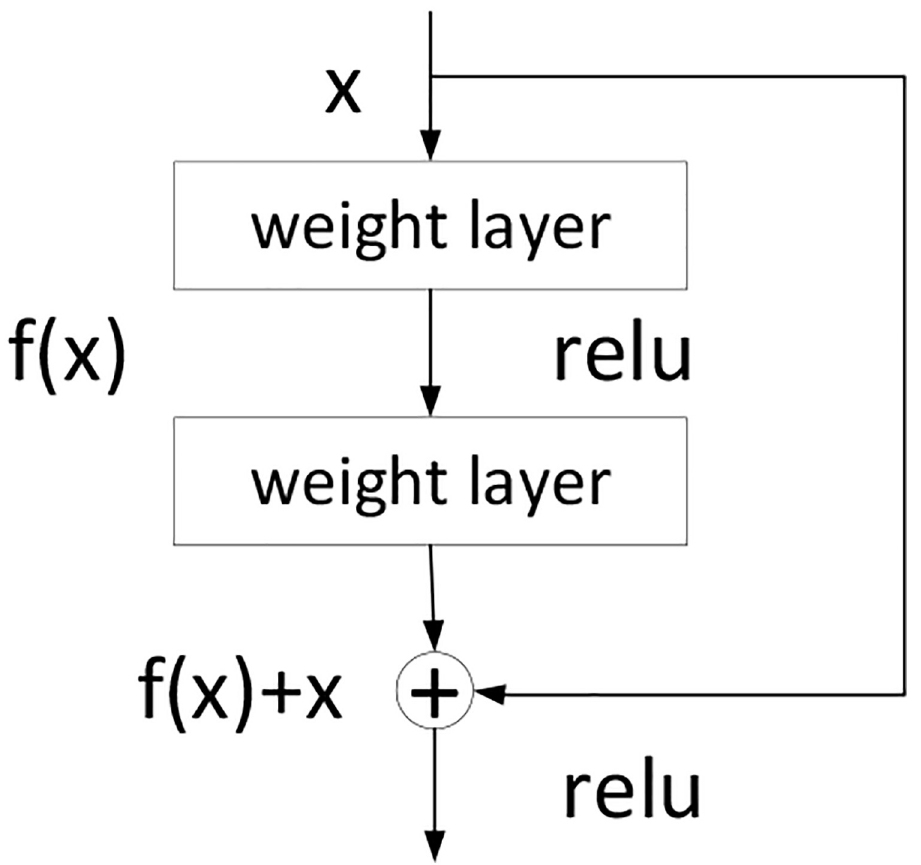
Fig 5. Residual block of